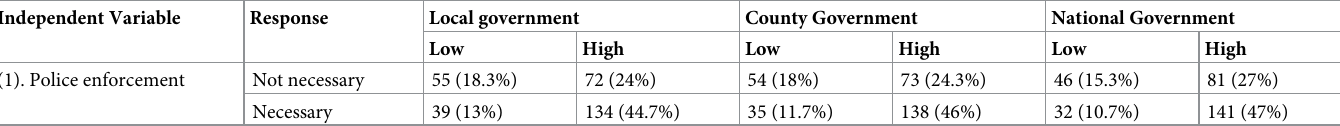
Table 6. Perception of police enforcement of COVID-19 measures among self-confirmed CHVs n = 300 (frequencies). Independent Variable